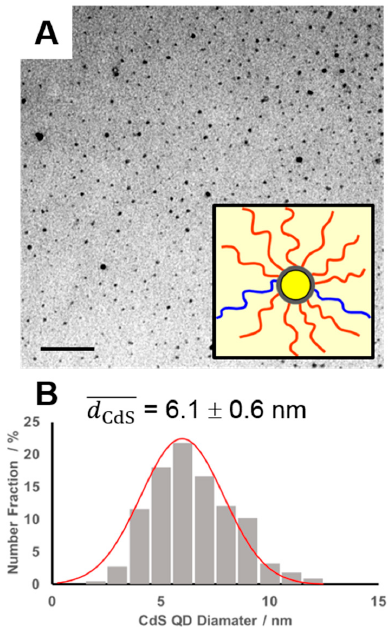
Figure 3. ( A ) TEM showing dark CdS QD cores of THF-cast PS/PMAA-CdS and associated schematic of PS/PMAA-CdS in THF (inset). Scale bar is 100 nm. ( B ) Size distribution and mean diameter of CdS QDs from TEM images. Error on mean value is the standard deviation of three average values determined in three different regions of the TEM grid.